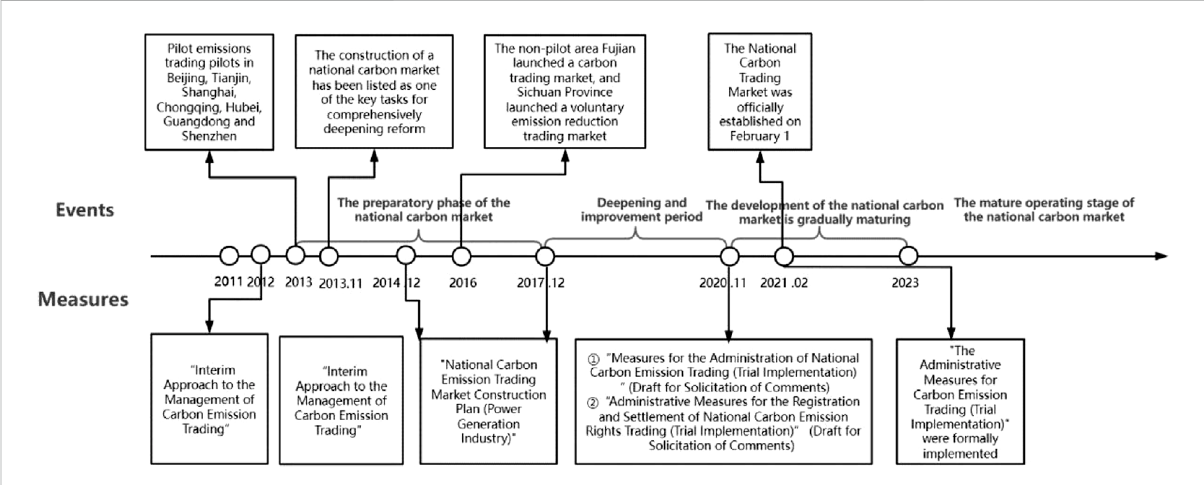
FIGURE 1 DevelopmenthistoryandprospectofChina ’ scarbonemissionstradingmarket.Source:Handmadeaccordingtothenationaldevelopmentand reform commission, the general of fi ce of ecology and environment and other relevant departments.